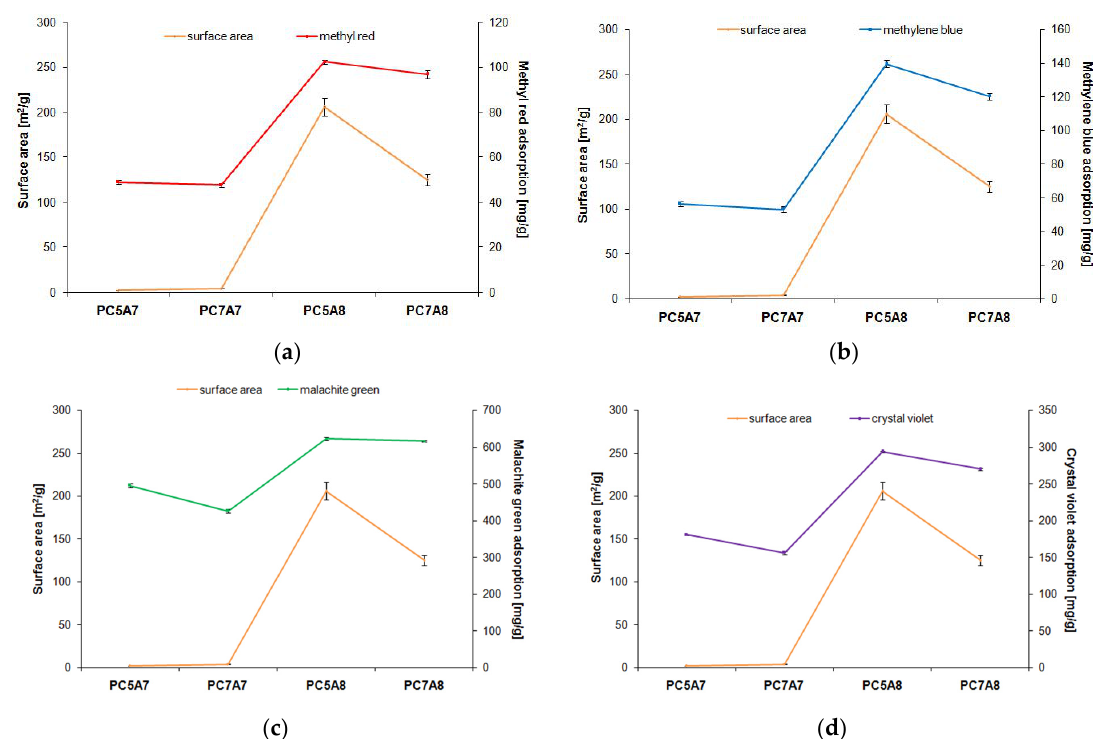
Figure 9. Dependence of the carbon adsorbents adsorption capacity on their surface area for adsorp- tion of: ( a ) methyl red, ( b ) methylene blue, ( c ) malachite green, ( d ) crystal violet.